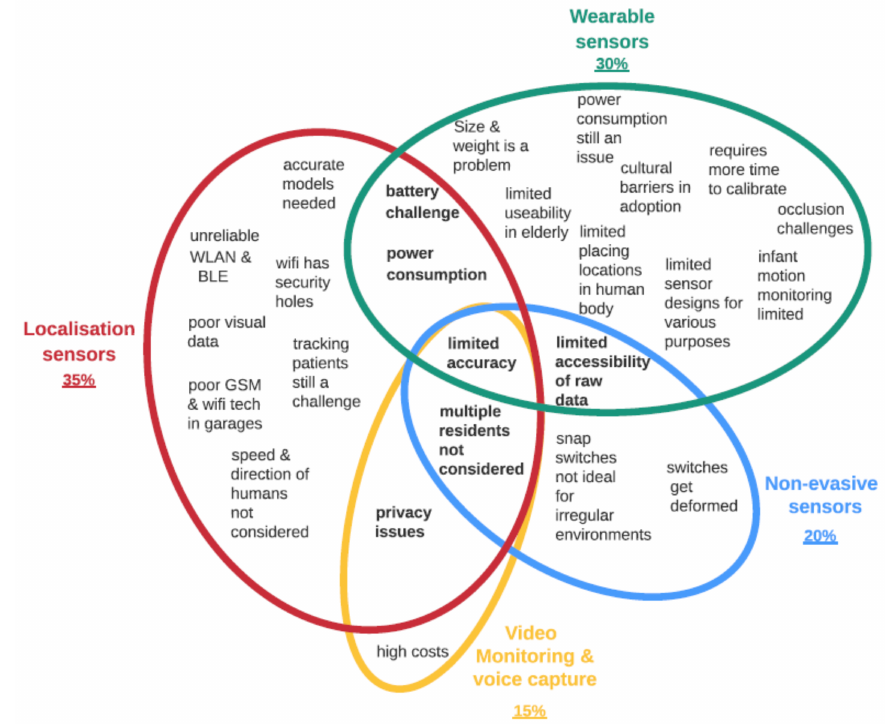
Figure 5. Highlighting sensor challenges in smart